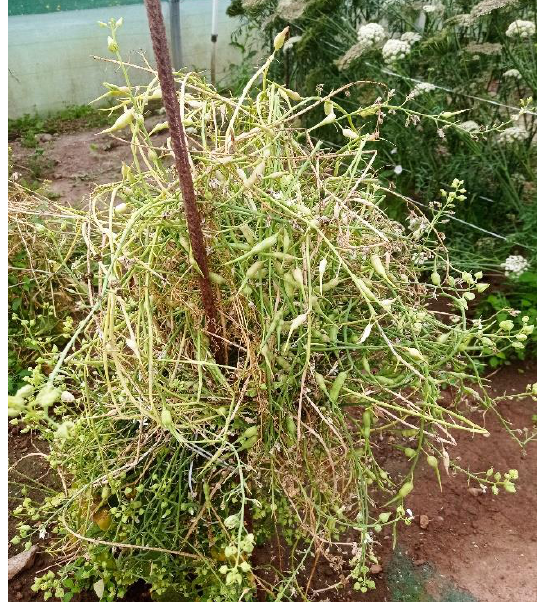
Figure 4. Raphanus sativus var. lobo infested by Contarinia nasturtii .